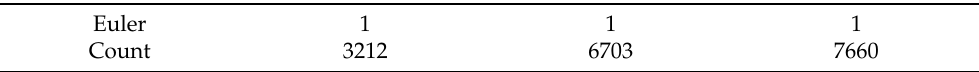
Table 1. First, second and third decomposition types (from left to right)—distributions of combinato- rial Euler characteristics of tetrahedron complexes.